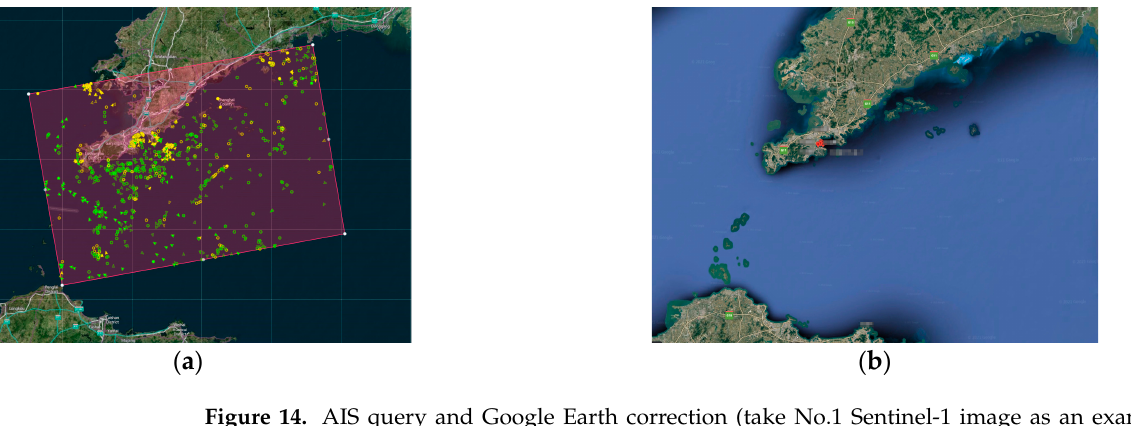
Figure 15. The ship annotation. ( a ) The OBB label in a SAR image; ( b ) the xml label file annotated by RoLabelImg. Each ship target is represented by an oriented bounding box as its ground truth. Where ( cx , cy ) is the centroid, w and h denote the width and height, and θ indicates the rotation angle; ( c ) the txt label file in DOTA format. Each ship is represented by four ordered vertices. Note that the top-left vertex is taken as the starting point, and the four vertices are arranged in clockwise order. So far, we have established the RSSD, and there have been 8013 SAR images with corresponding annotation files, including 21,479 ship targets annotated by rotated ground truths. Figure 16 displays ship ground truth annotations of diverse SAR images in RSSD. ( a )